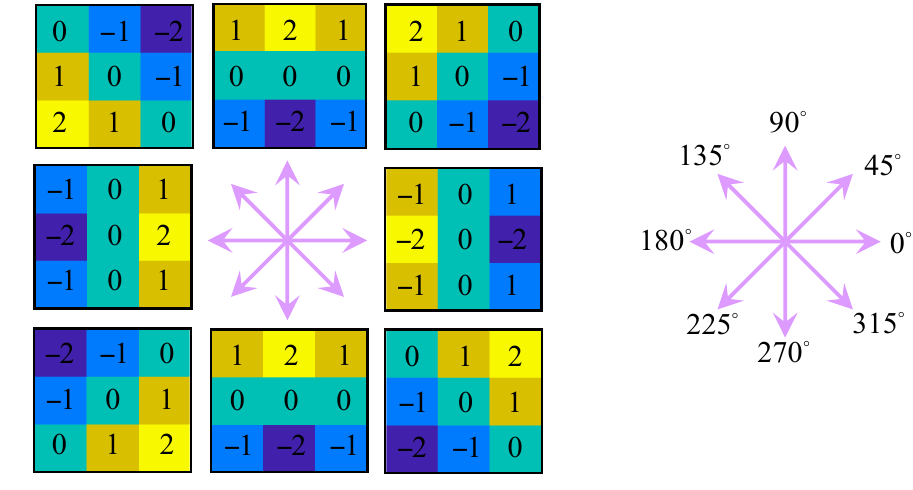
Figure 3. Improved Sobel operator.